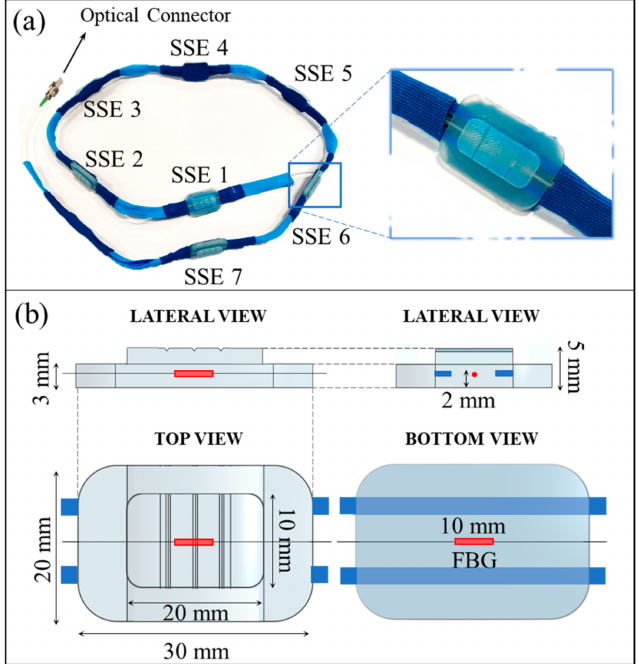
Figure 1. The wearable system. ( a ) A picture of the wearable system (on the left), together with a close-up view of one of the seven identical sensing elements (on the right); ( b ) Rendering and features of the sensing elements shown in lateral, top, and bottom